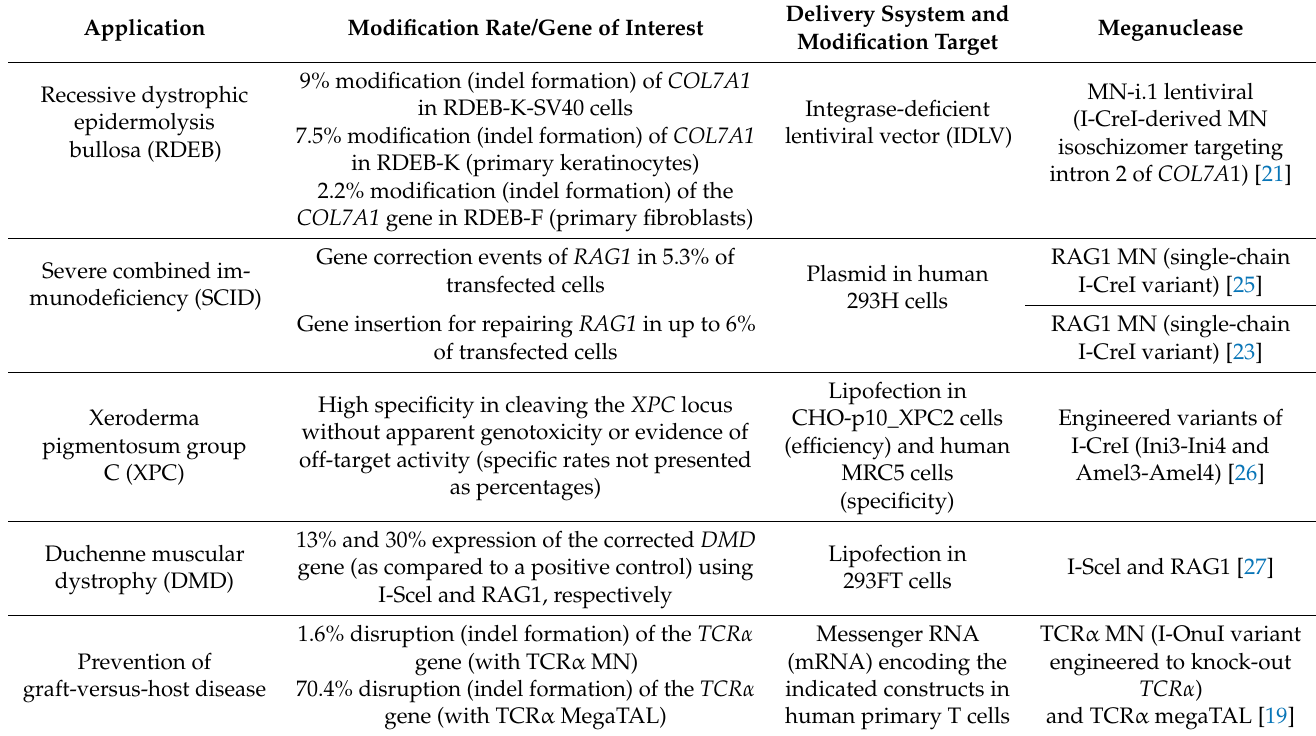
Table 1. Modification rates obtained using MNs in clinically relevant